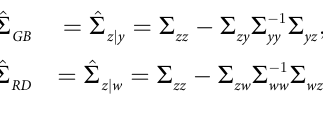
Fig 7. Best directional statistics subject to different upper limit on condition number of S the line on the bottom, to 10 4 associated with the line on top, GB: − � − , RD: Solid lines, MA: ‥ o ‥ (MA 10 on the bottom and MA 50 on top). Higher plots represent better performance.